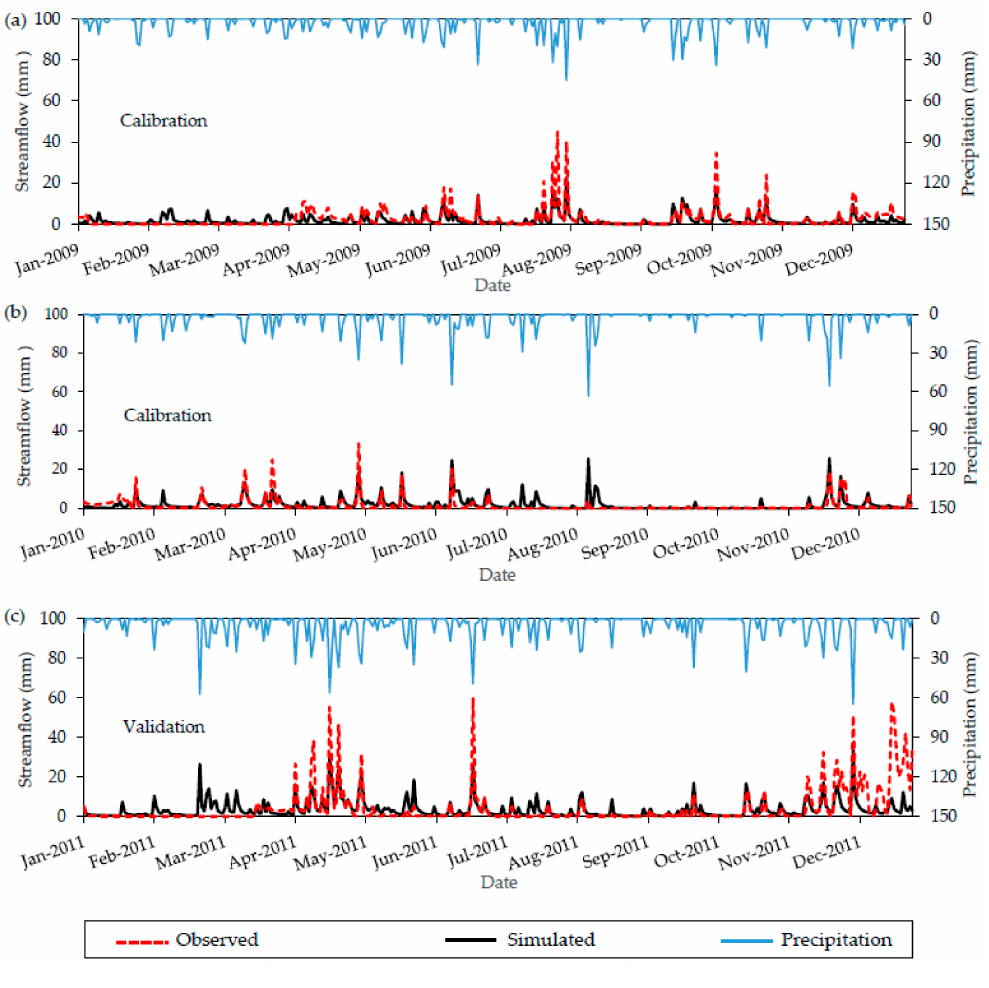
Figure 4. Plots of ( a , b ) calibration (NSE = 0.54, R 2 = 0.53, RMSE = 3.12, and PBIAS = − 2.40) and ( c ) validation (NSE = 0.40, R 2 = 0.48, RMSE = 5.27, and PBIAS = 13.84) of the VELMA model output at